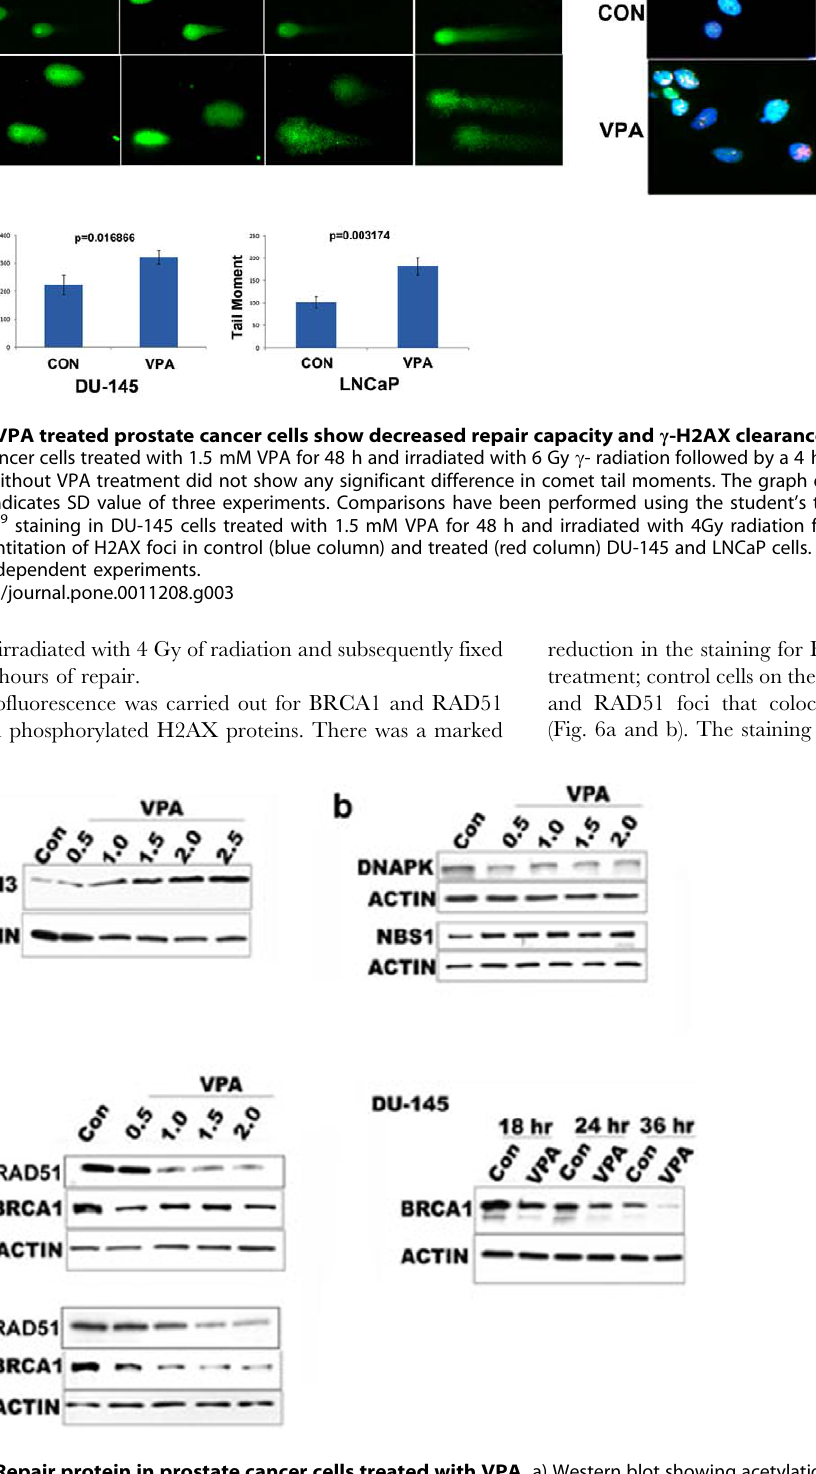
Figure 4. Repair protein in prostate cancer cells treated with VPA. a) Western blot showing acetylation of histone H3 protein in DU-145 cells after treatment with different doses of VPA for 48 h. b) DNAPK and NBS1 protein levels in VPA treated DU-145 cells for 48 h. c) Western blot showing RAD51 and BRCA1 protein levels in LNCaP and DU-145 cells treated with varying dosage of VPA for 48 h. Blot on the right shows DU-145 cells treated with 1.5 mM VPA for varying timepoints probed for BRCA1 protein.